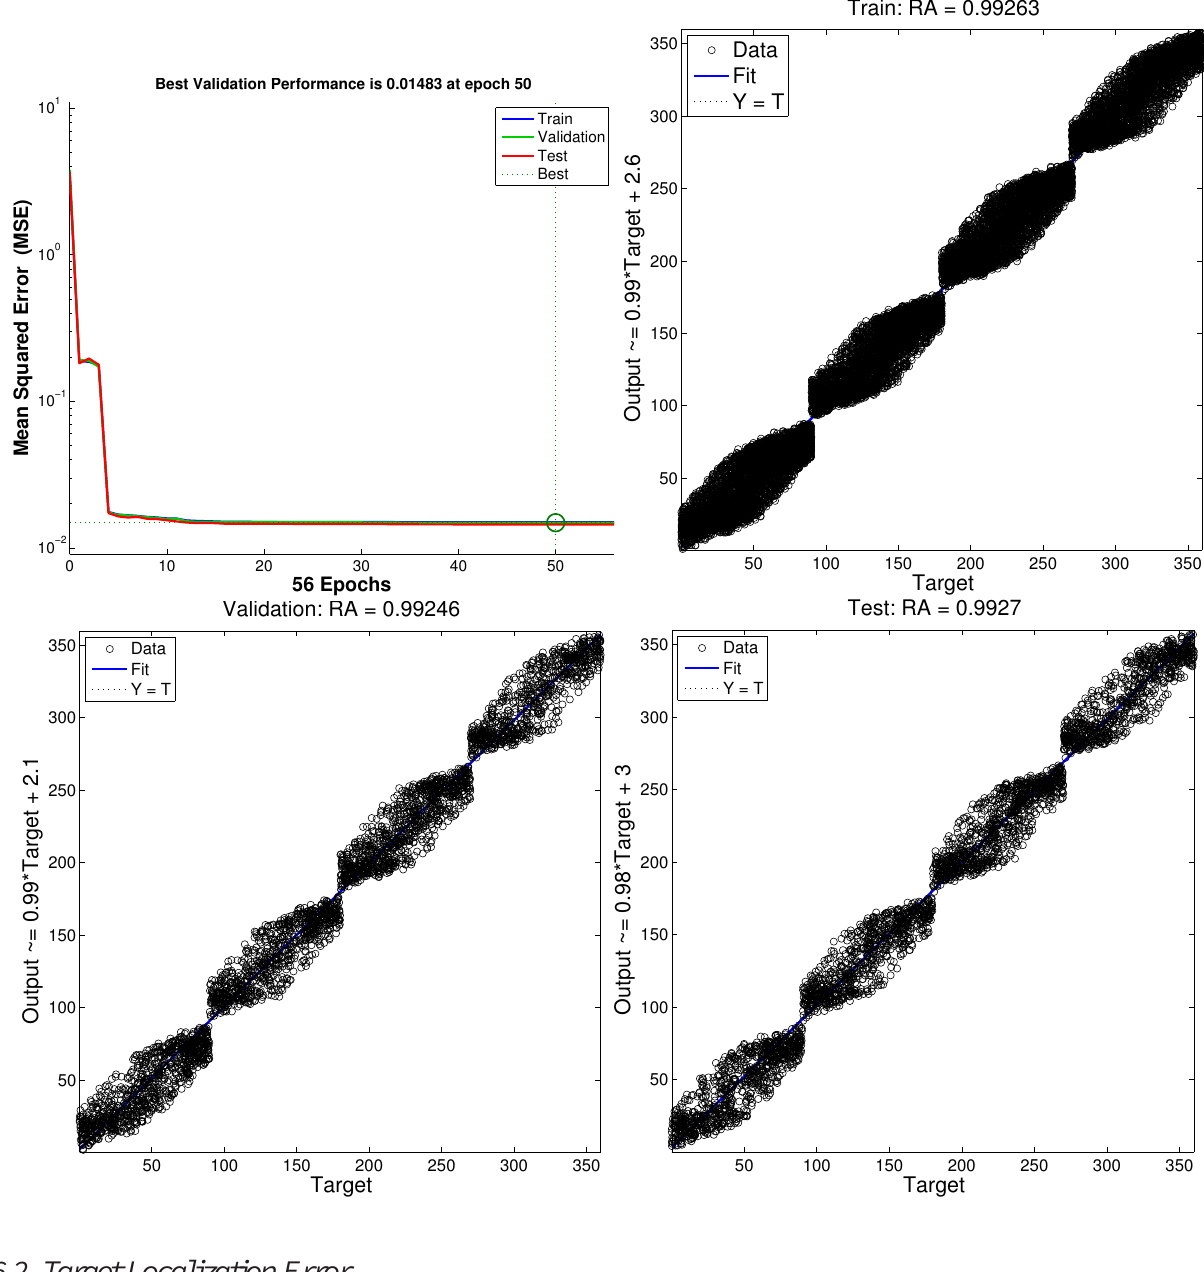
Figure 11. The performance analysis of the network ( top left ); the regression analysis between the network response and the corresponding targets: the training case ( top right ), the validation case ( bottom left ) and the test case ( bottom right